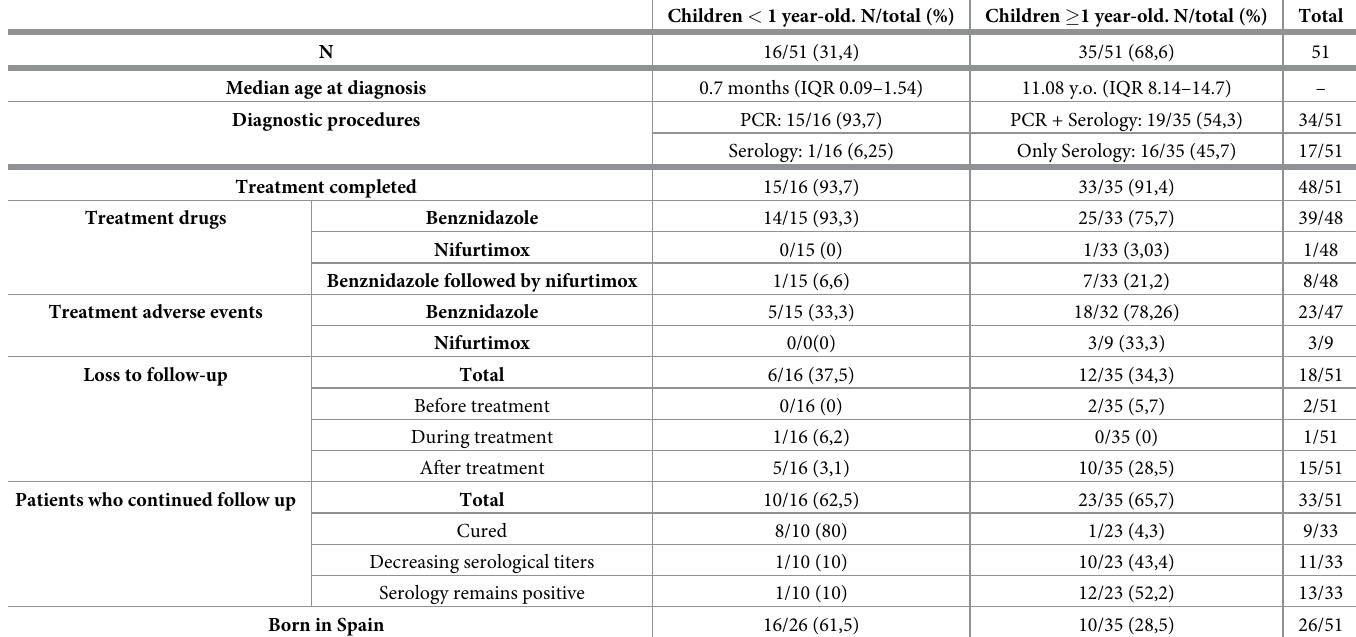
Table 1. Comparative table regarding age ( < 1 year-old vs > 1